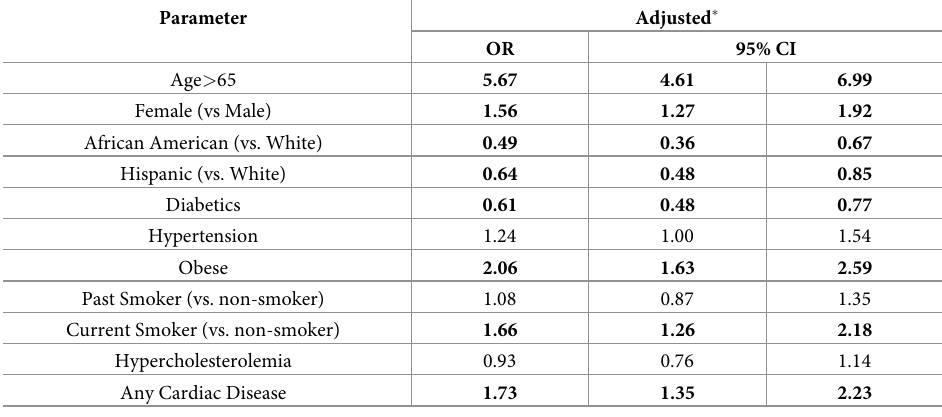
Table 5. Factors associated with reclassification to eGFR cys < 60 among participants with eGFR cr �